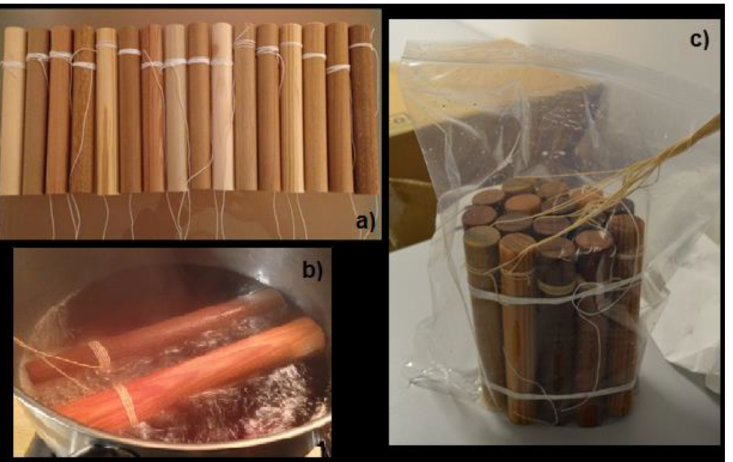
Figure 1. Water imbibed phantom. The phantom implementation is made up of sixteen wooden cylinders of different wooden species (see Table 1) soaked in water. ( a ) The sixteen cylinders of different ligneous species; ( b ) the procedure for speeding up water imbibition; ( c ) a phantom con- sisting of sixteen wooden cylinders soaked in the water tied together with a string and inserted in a plastic bag. The sample displayed in ( c ) was inserted in the rf coil of the clinical scanner used for the MRI